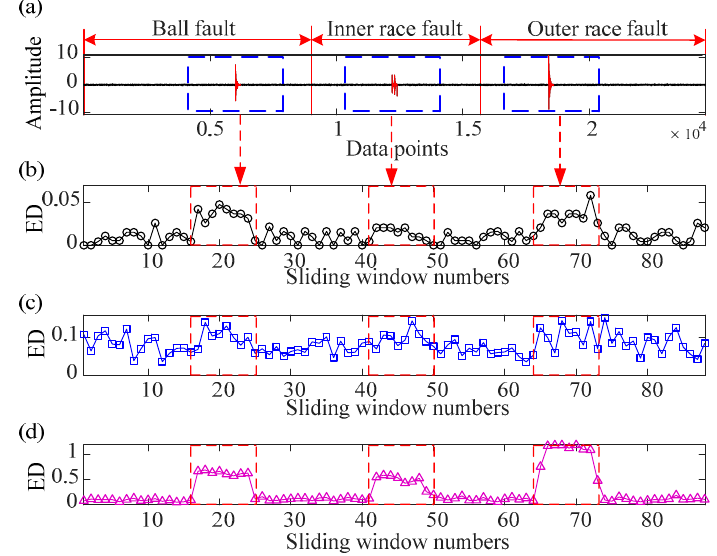
Figure 5. Results of sliding window analysis of Lempel-Ziv complexity (LZC), MLZC, and HLZC methods: ( a ) the simulated impulsive signal, ( b ) the Euclidean distance (ED) value of LZC, ( c ) the ED value of MLZC, and ( d ) the ED value of HLZC.